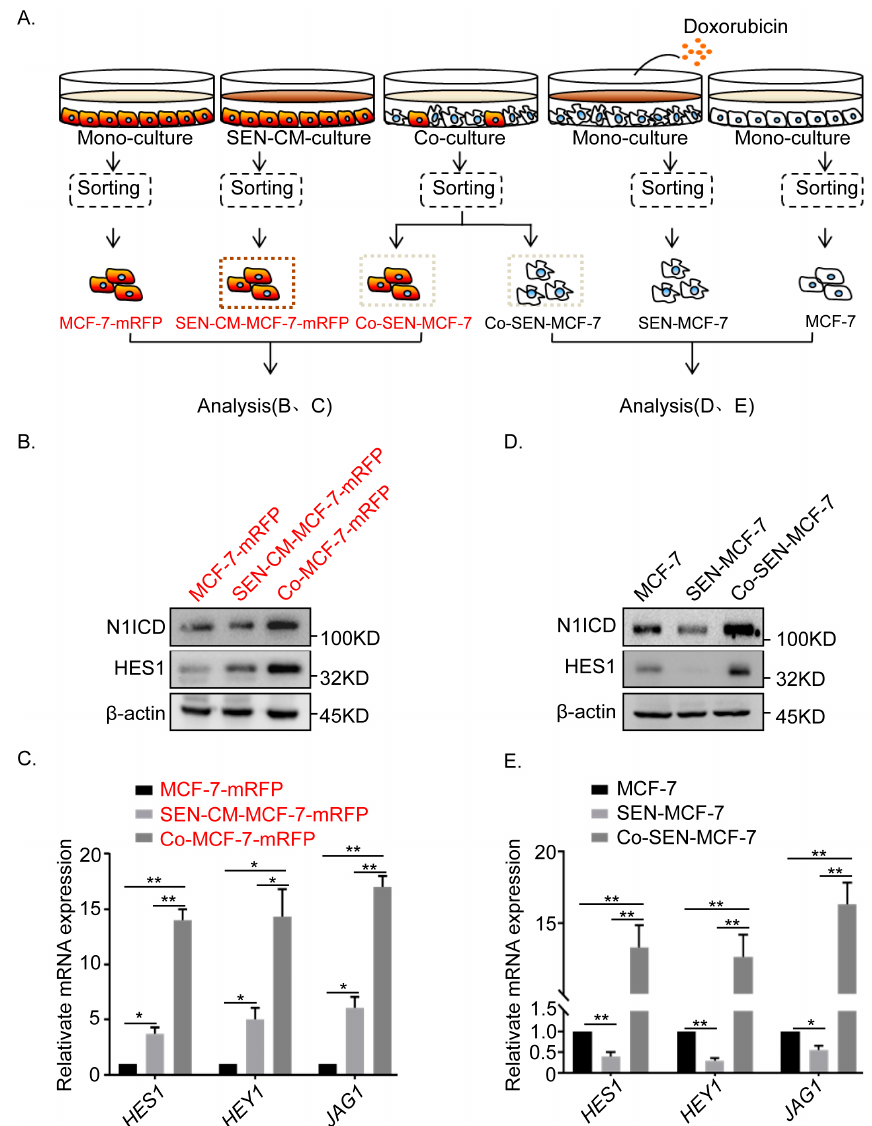
Figure 3. Activation of Notch signaling in both senescent and adjacent non-senescent breast cancer MCF-7 cells. ( A ) Scheme showing the experimental setup. Flow cytometry sorting of collected breast cancer cells after co-culture or monoculture. ( B ) Immunoblot analysis of protein expression of active Notch1 intracellular domain (N1ICD) and the canonical Notch target, HES1, assessed in MCF7-mRFP cells subjected to the indicated treatments. ( C ) RT-qPCR analysis of expression of target genes HES1 and HEY1 and JAG1 in MCF7-mRFP cells subjected to the indicated treatments (error bars indicate mean SD, n = 3 experimental replicates,* p < 0.05, ** p < 0.01). ( D ) Immunoblot analysis of protein expression of active Notch1 intracellular domain (N1ICD) and the canonical Notch1target, HES1, assessed in MCF-7 cells subjected to the indicated treatments. ( E ) RT-qPCR analysis of gene expression of target genes HES1 and HEY1 and the JAG1 ligand of Notch in MCF-7 cells subjected to the indicated treatments (error bars indicate the mean SD, n = 3 experimental replicates,* p < 0.05, ** p <